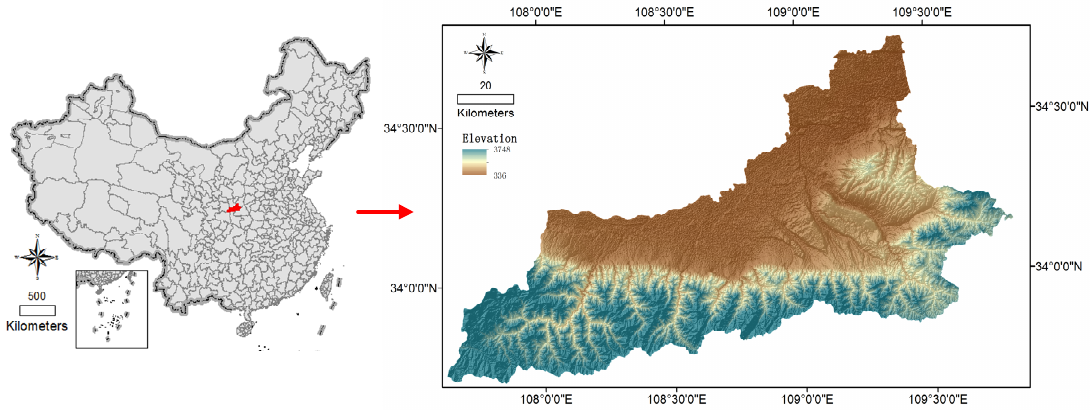
Figure 1. Location of Xi’an in China.